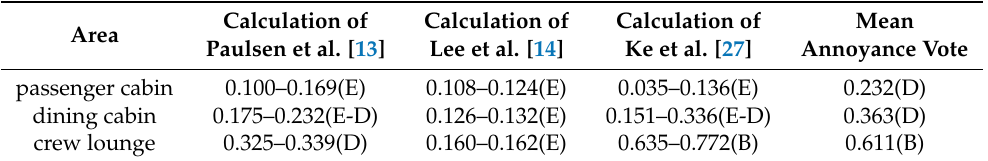
Table 5. The statistics of the calculated combined annoyance rate and respondents’ annoyance votes in three cabins. Calculation Area